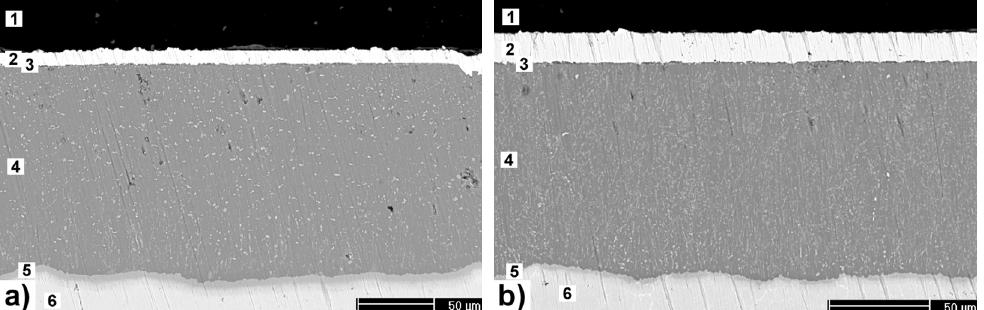
Figure 11. Cross-sections of aluminized, completely ground specimens after 336 hours at 833 K in N 2 (cid:3) 1000 ppmv HCl (cid:3) 15 % H 2 O (cid:3) 13 % O 2 . a) P91. b) HCM12A. On both images: 1) Mounting. 2) Nickel coating. 3) (cid:2) (cid:3) Al 2 O 3 . 4) Al 5 Fe 2 matrix phase (as grey in images) with AlCr 2 and Cr 3 Si precipitate phases (both as white in im- ages, with the latter shown slightly brighter). 5) AlFe phase. 6) Substrate.